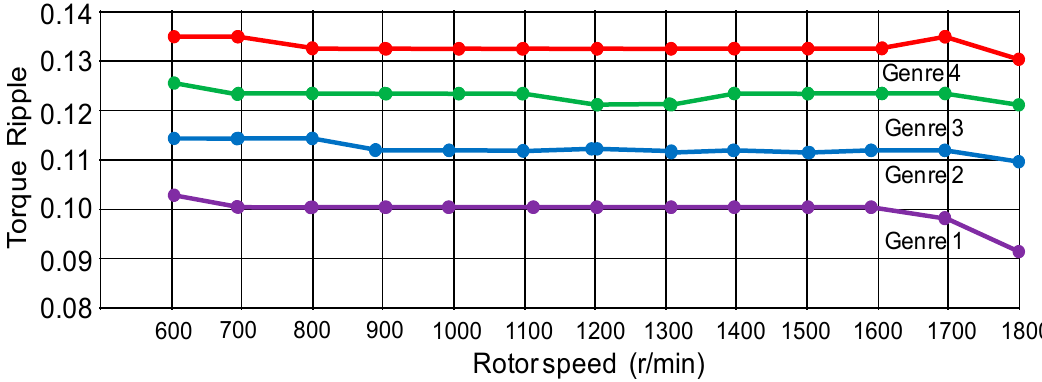
Figure 7. Line chart of comparisons of output torque for 4 kinds of six-phase synchronous reluctance motors mounted to centrifugal compressor with various speeds.